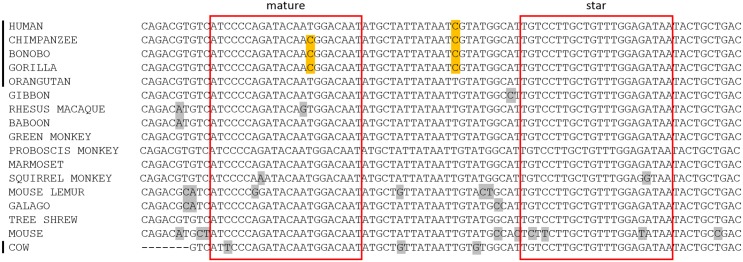
Alignment of miR-2355 homologous sequences.The black line indicates species that have experimental support for the transcription of miR-2355, either in miRBase (human, cow) or from this study (chimpanzee, bonobo, gorilla, and orangutan). The red boxes outline the mature and star sequences within the miRNA. Variants only found among the great apes are highlighted in yellow, while all other variants are marked in grey. Humans have experienced a reversion at position 15 of the mature miRNA, restoring that nucleotide to its ancestral state.